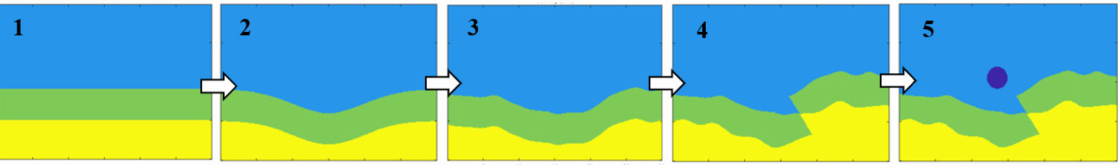
Figure 9. Geological model generation